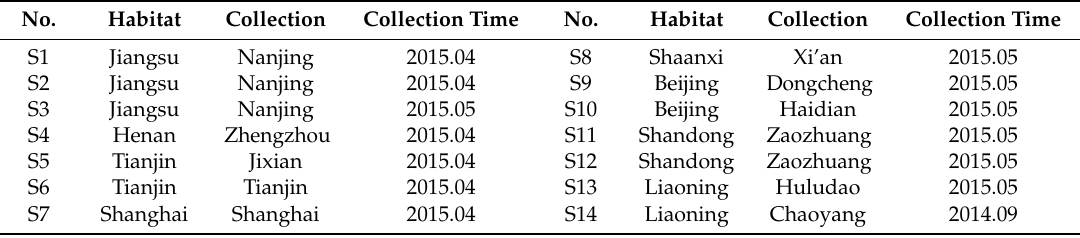
Table 4. Information for the investigated